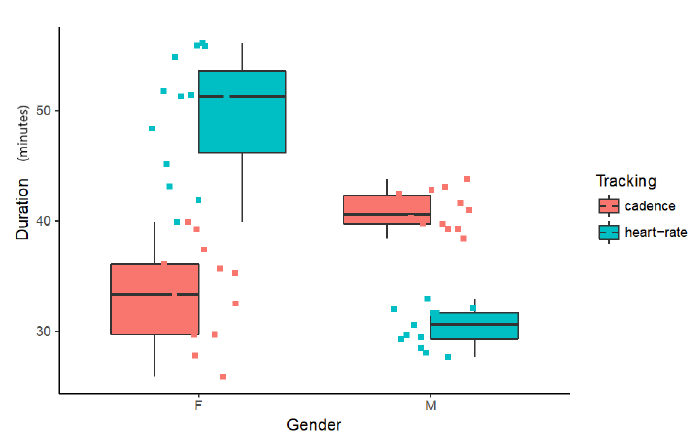
Figure 4. Boxplot for Duration in minutes indicated by Gender and Tracking type.